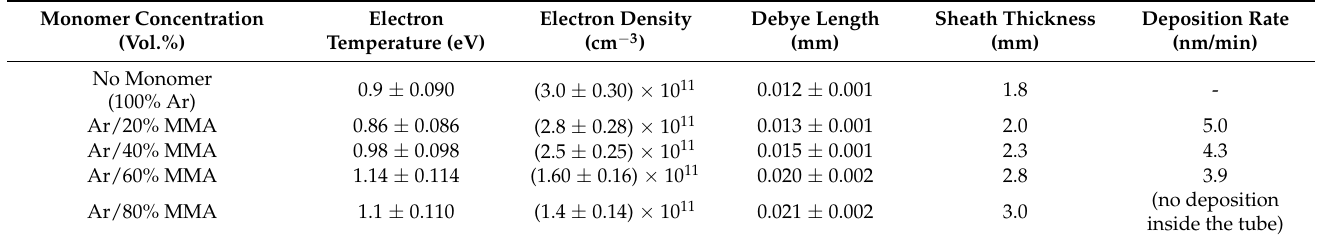
Table 2. Results of calculations for T e and n e , as well as sheath thickness, as a function of MMA concentrations, (RF power = 100 Watt).